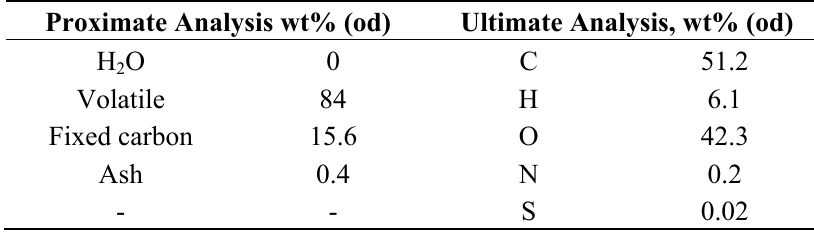
Table 1. Proximate and ultimate analysis results of Pinus radiata